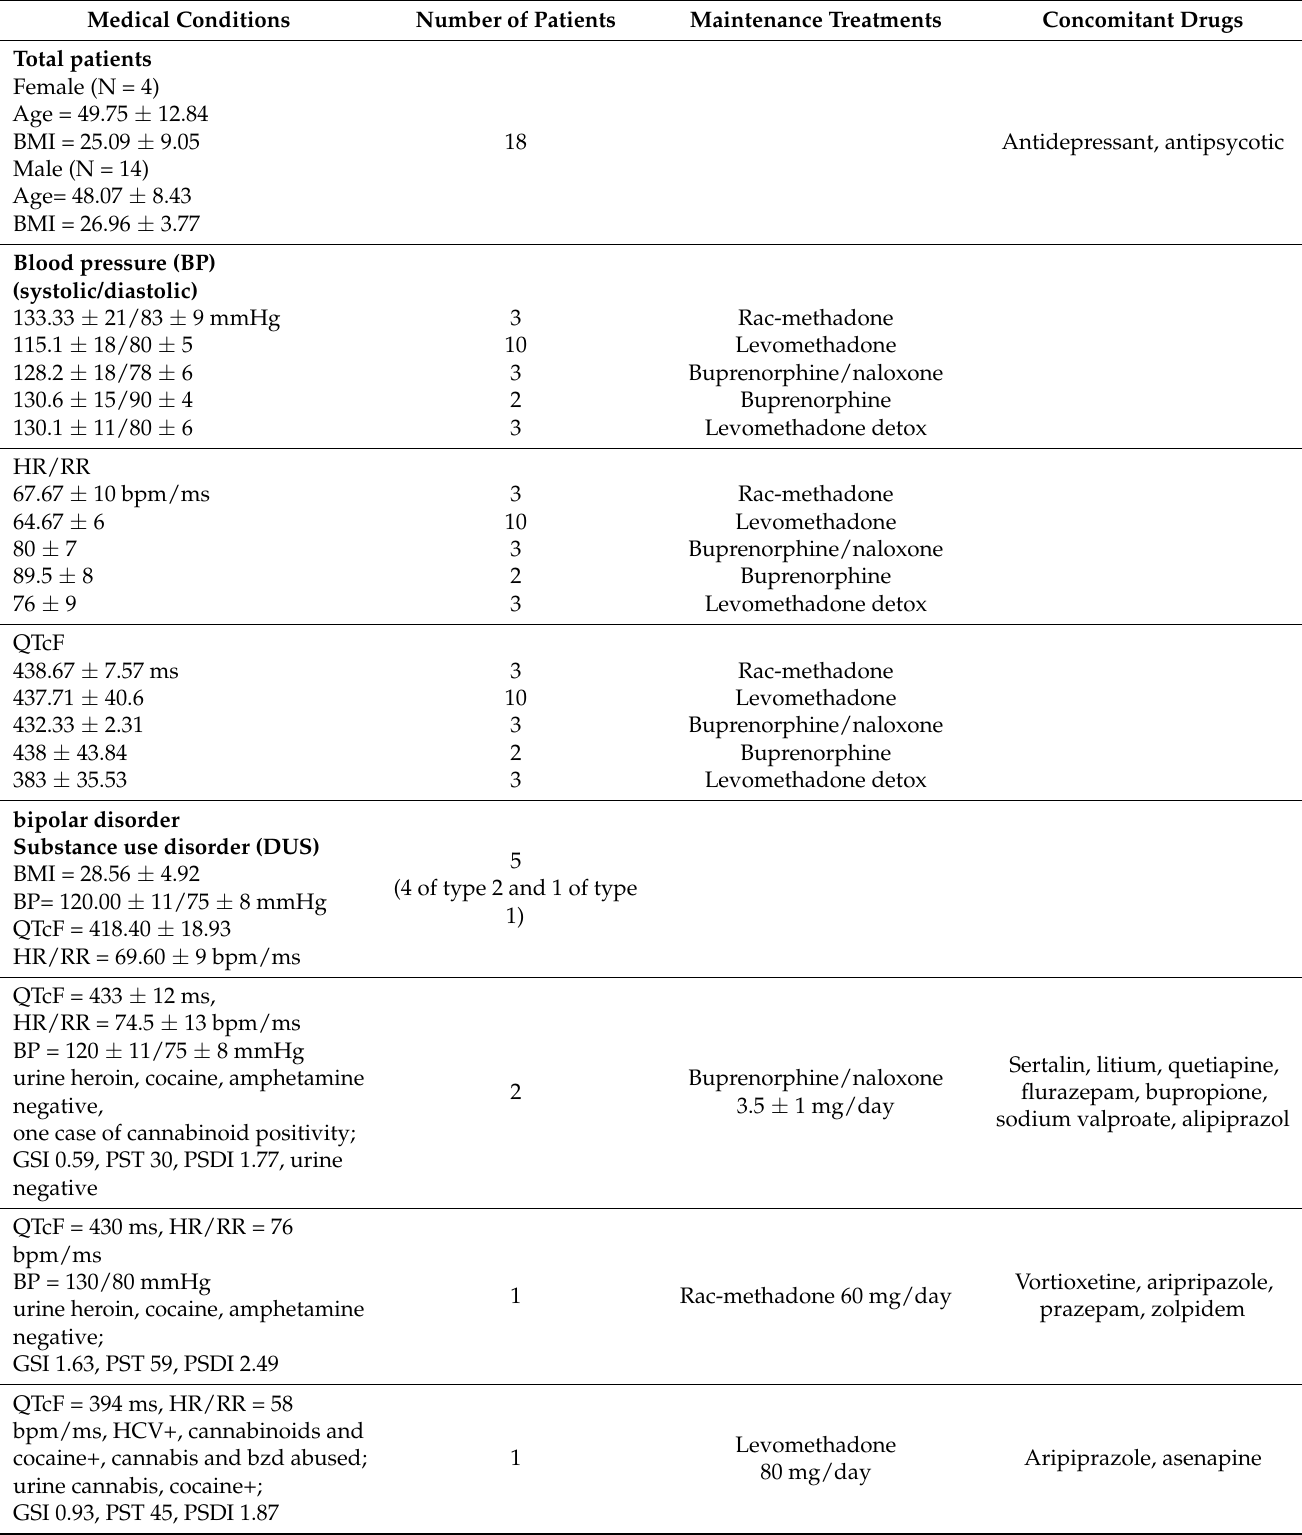
Table 10. The medical condition of recruited patients with a double diagnosis. QTcF = QT interval of the ECG trace (corrected by the Fridericia formula), BP = blood pressure, bpm = beat per minute, HR = heart rate, RR = RR intervals of the ECG, BMI = body mass index, GSI = global severity index, PST = positive symptom total, PSDI = positive symptom distress